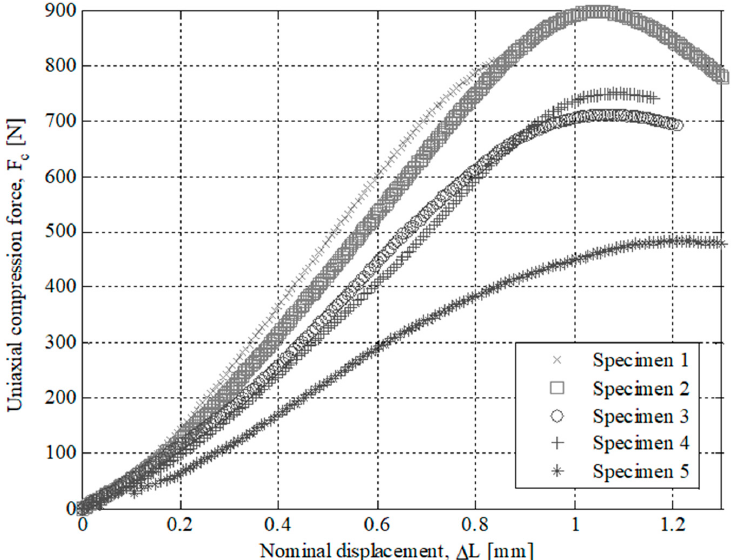
Figure 8. Curves for X-Axis manufactured specimens related to Uniaxial compression force versus nominal displacements.